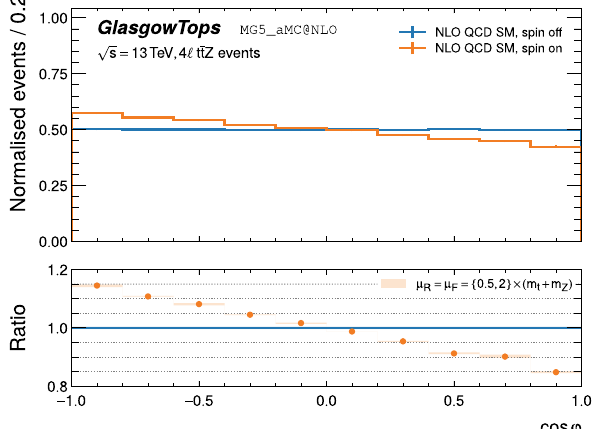
Fig. 2 Normalised distribution of cos ϕ in 4 (cid:10) t ¯ tZ events, under the assumption of SM-like (orange) and no spin correlations (blue). In the bottom panel, the orange error bars and the blue error band represent the Monte Carlo statistical uncertainties on these two distributions. The orange error band further corresponds to the scale uncertainty obtained by varying μ R and μ F together by a factor of